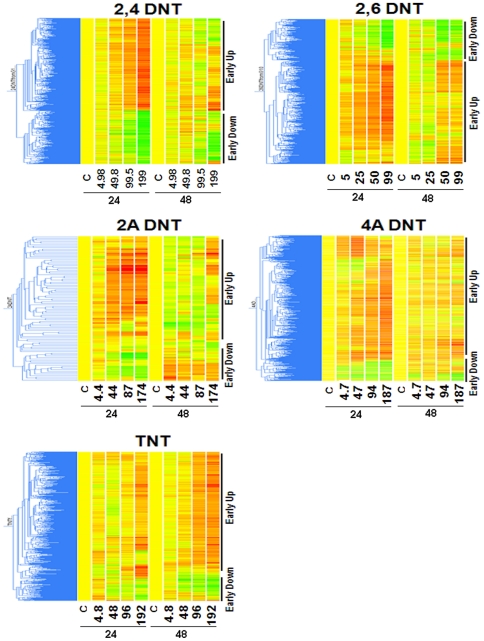
Hierarchical clustering of significantly regulated genes.Most significantly regulated transcripts of each compound were used for constructing gene clustering trees across different conditions including control and 4 different doses at 24 h or 48 h for each compound. Pearson correlation algorithm with average linkage was performed to calculate distances between transcripts. Two distinctive gene expression patterns: early up-regulated (early up) and early down-regulated (early down) gene expression patterns were indicated on the right of each cluster.